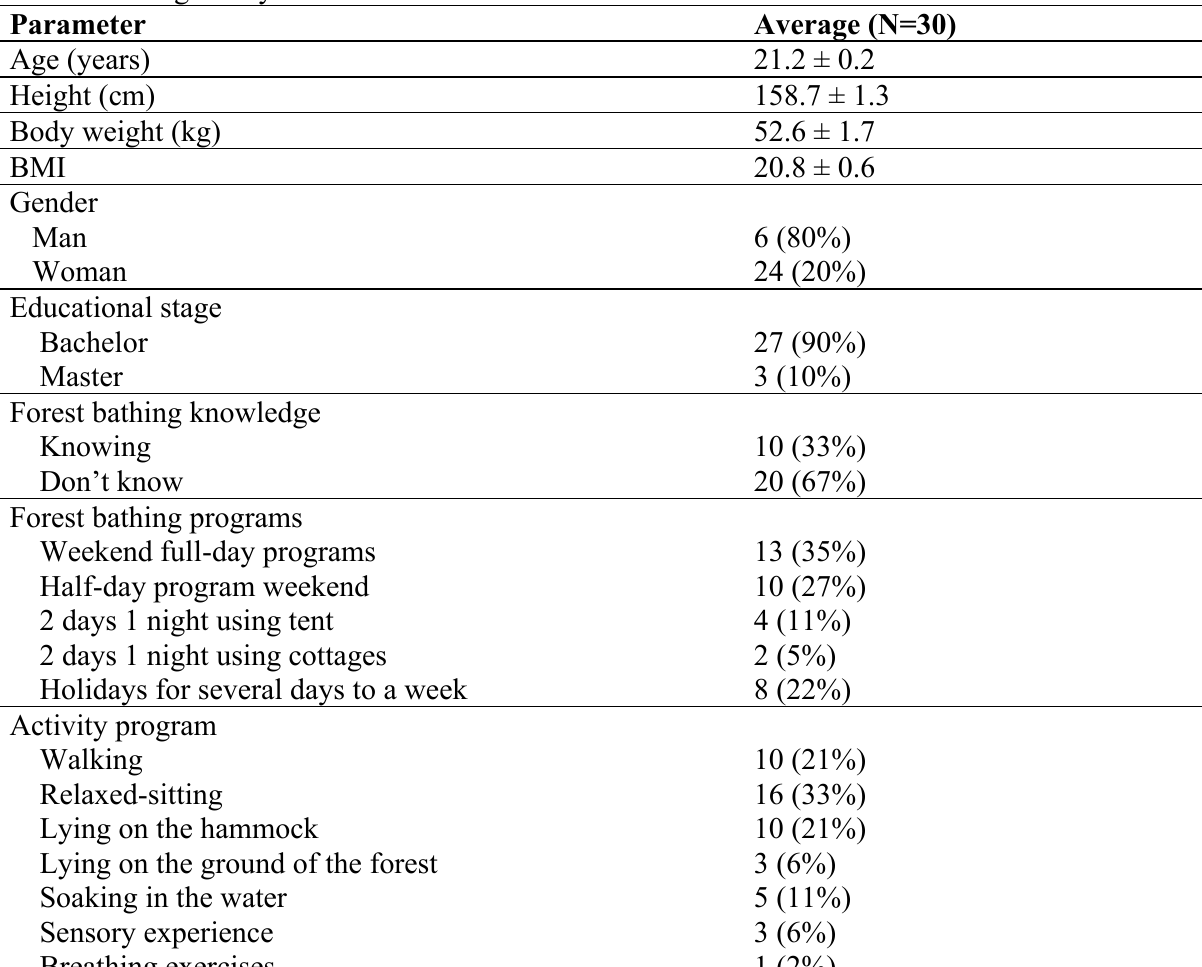
Table 2. Characteristics of subjects who took part in the forest bathing program at urban greenspaces in Bogor